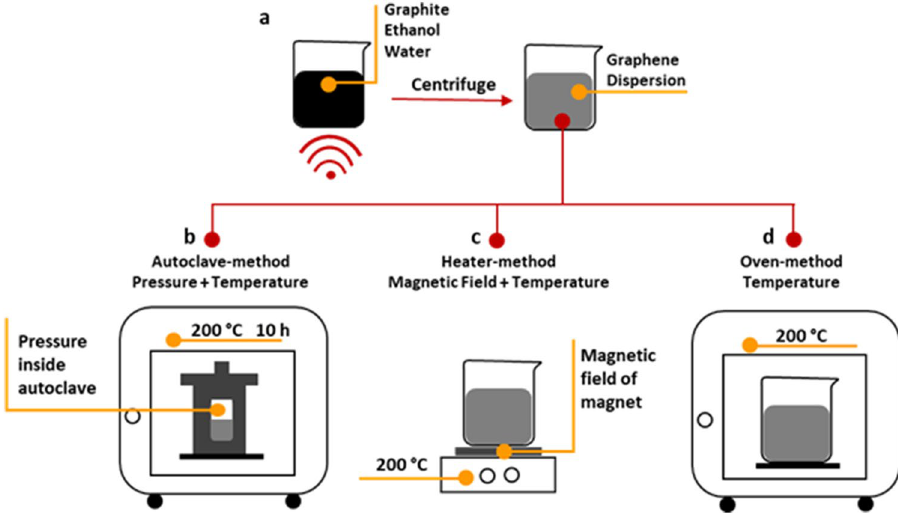
Figure 1. Dispersion of graphene and three different methods for investigating the effect of temperature, pressure, and magnetic field on the magnetization of graphene. ( a ) Dispersion of graphene dispersion by the liquid-phase exfoliation method. ( b ) Appling temperature and pressure by the Autoclave-method. ( c ) Appling magnetic field and temperature by the Heater-method. ( d ) Appling temperature by the